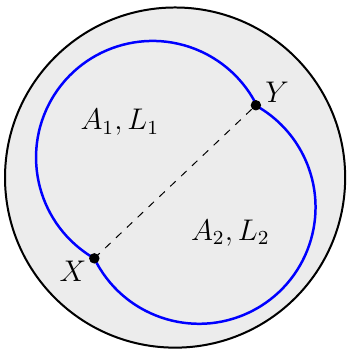
Figure 2 . Geometric minimization problem. The gray circle is euclidean AdS 2 . The blue line is the cut-o(cid:11) boundary of AdS. X and Y correspond to the insertions of the two-point function. We separate the boundary in two arcs of length L 1 , L 2 and enclosing area A 1 , A 2 . After solving for (cid:18) and (cid:18) , one recovers the saddle-point formulas of (6.2). 11 In particular, 1 2 the saddle-point gives k (cid:24) O ( C ), (cid:18) (cid:24) O (1) and S (cid:24) O ( C